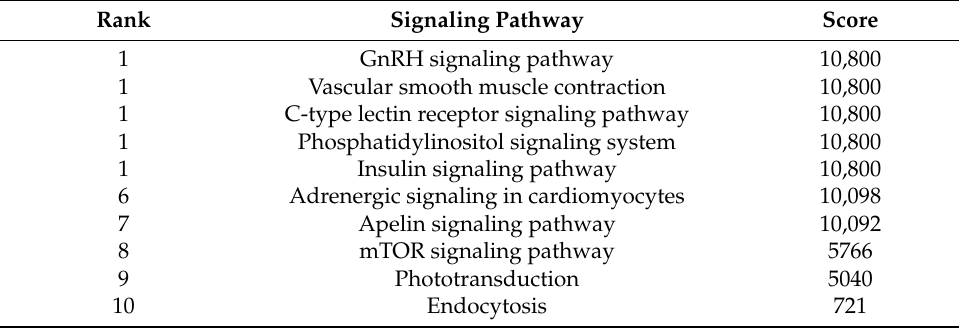
Table 1. Top 10 hub pathways of up-regulated genes ranked by MCC method. Rank Signaling Pathway